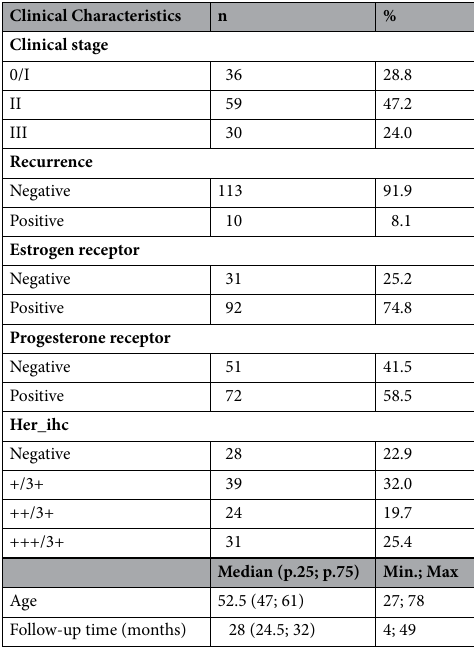
Table 2. Clinical characteristics of the patients. +/3+, ++/3+ or +++/3+ are standard positivity index. p.25; p.75: 25–75; Min. minimum, Max.